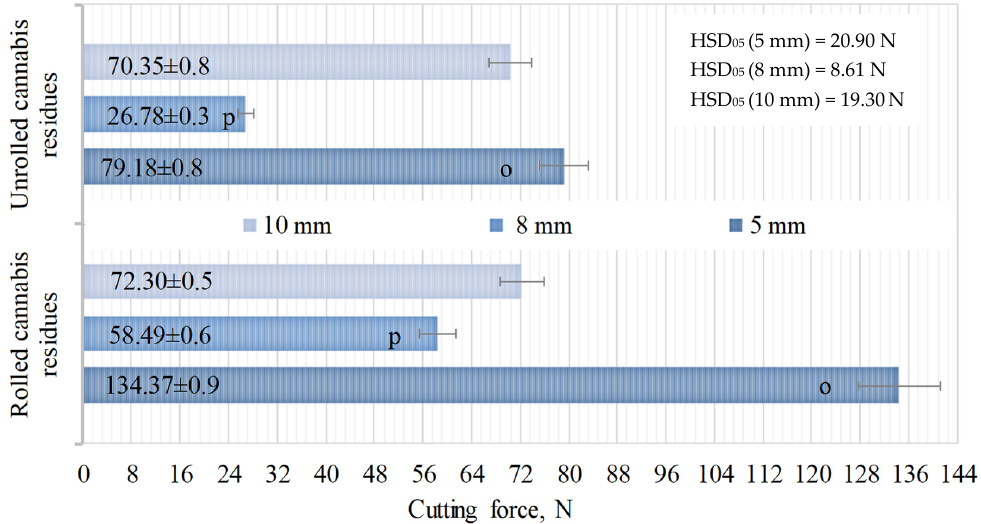
Figure 6. Cutting force demand for rolled and unrolled cannabis residues of different diameters. Columns marked with the same letter mean the results have significant differences (probability level P<0.05).